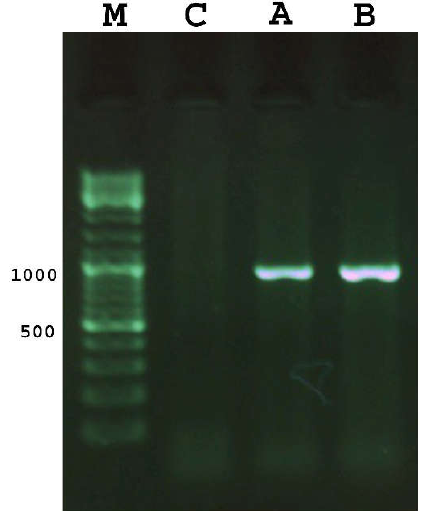
Fig. 1. PCR amplification of the barely genome using the specific hva1 primers to amplify the Hva1 gene: Lane A, B corresponds with the hva1 products isolated from barely. Lane C corresponds to the negative control. Lane M corresponds with a 100 bp ladder DNA size marker.